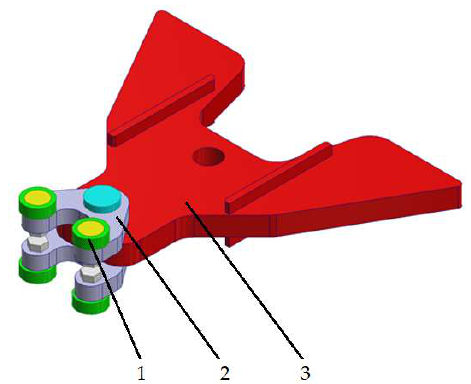
Figure 8. Follow-up rollers installed on the wedge plate. In the figure: 1—roller, 2—bracket, 3—wedge plate.